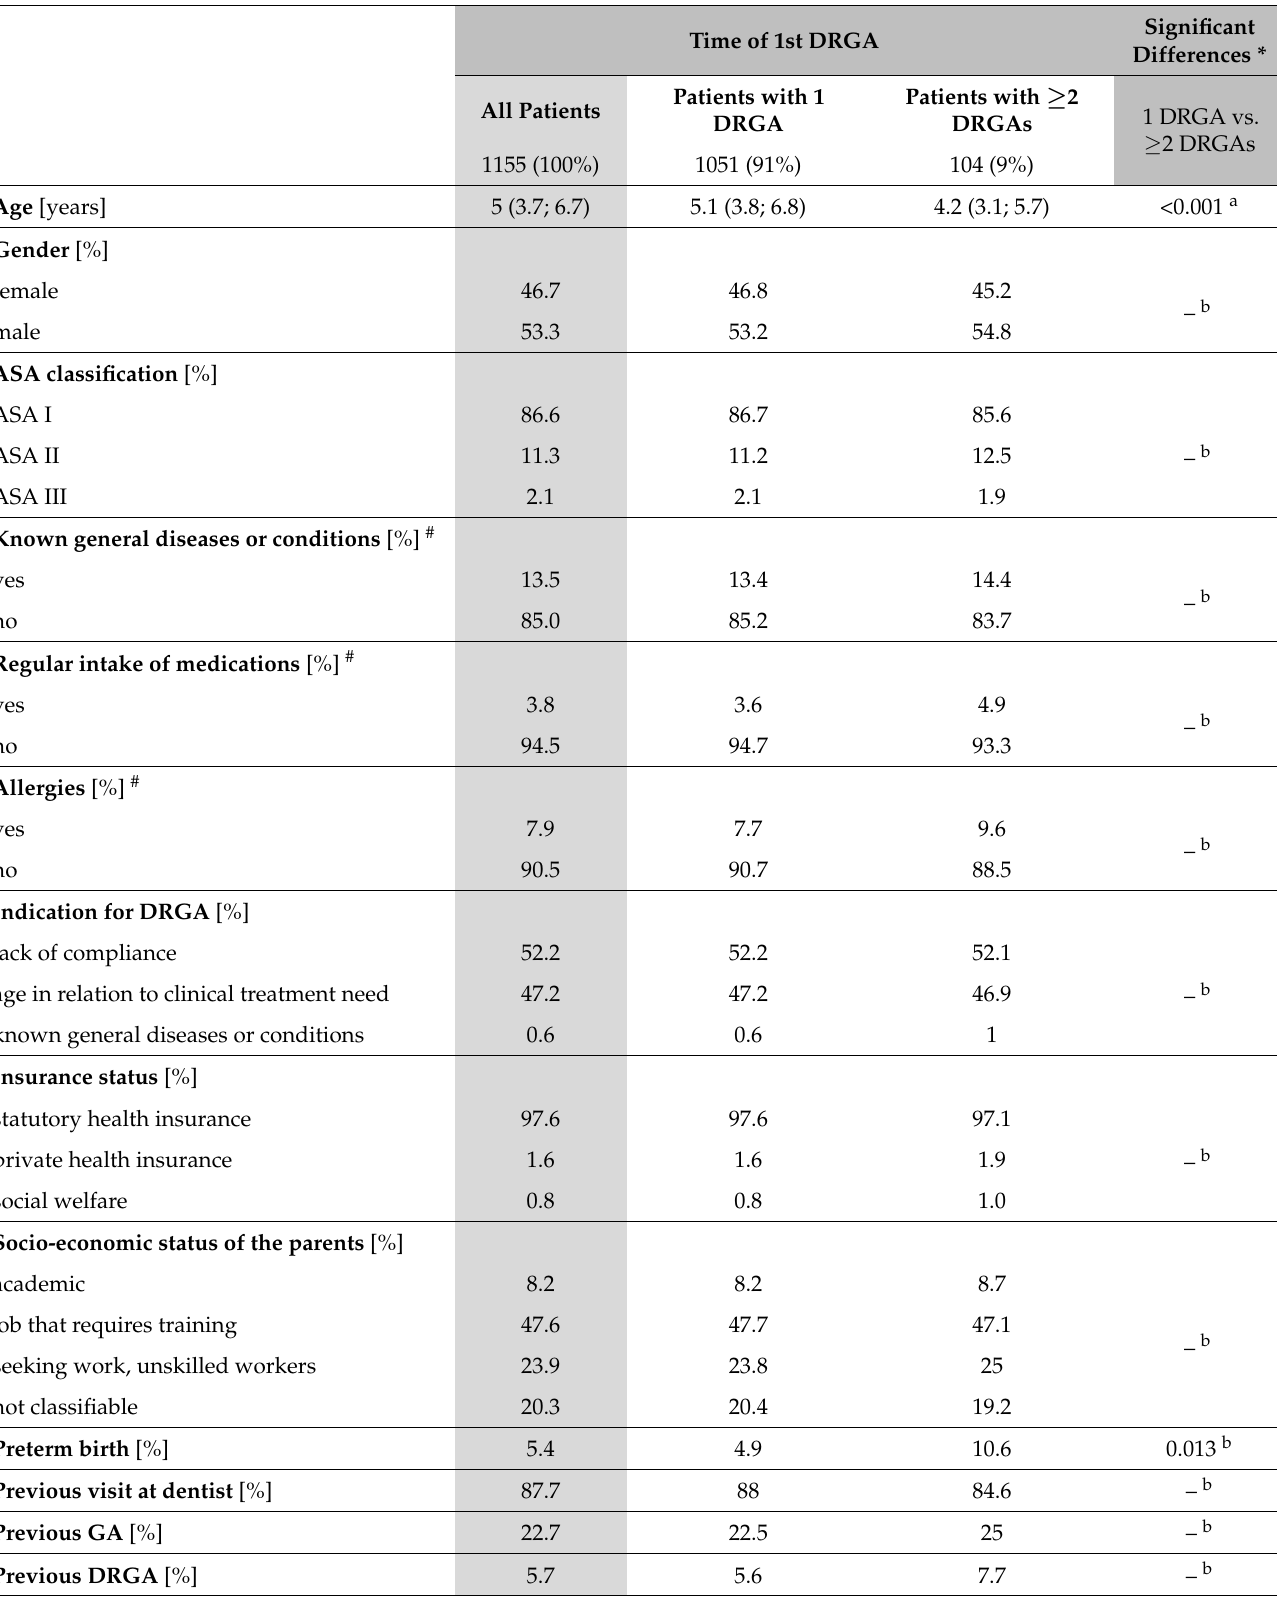
Table 1. Demographic and anamnestic data of all included patients at the time of their first